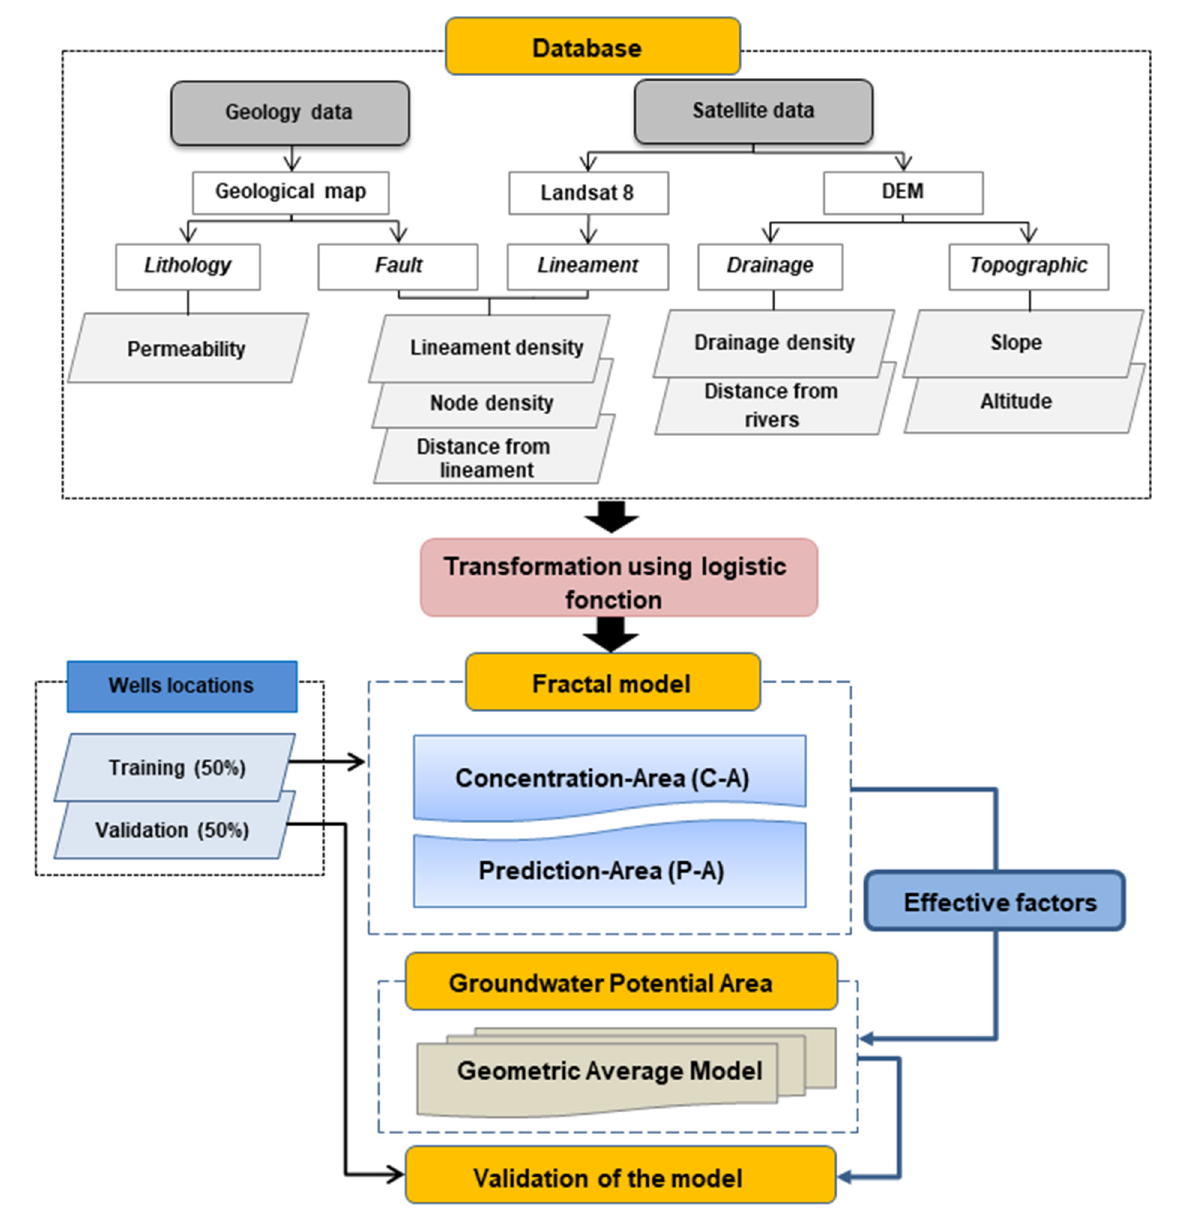
Figure 3. The methodology used for editing the potential groundwater map for the Tissent basin.